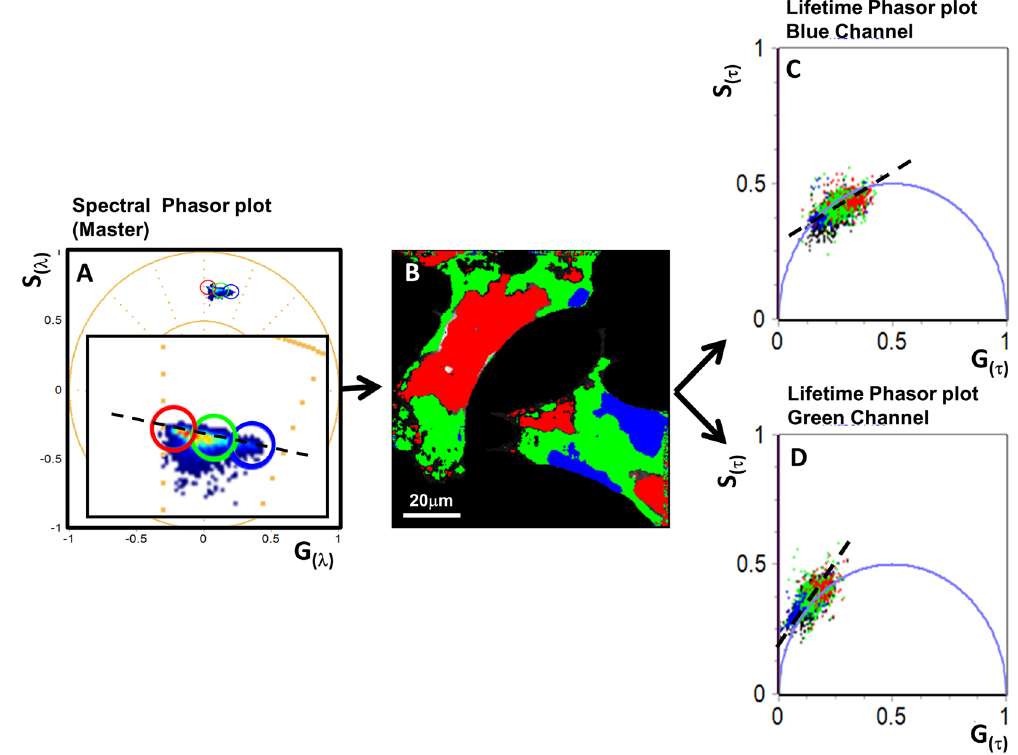
Figure 3. Multi-D phasor analysis of the LAURDAN fluorescence from NIH-3T3 cell membranes. ( A ) Spectral phasor plots (master) and cursor selection (red, green and blue) of different ROI in the phasor plot. The inner panel is the zoomed region of the phasor plot for better viewing. ( B ) Color-coded images generates by the cursor selection according to the master phasor plot. ( C , D ) Lifetime phasor plots (Blue and Green channels, see Material and Methods for the channel transmission